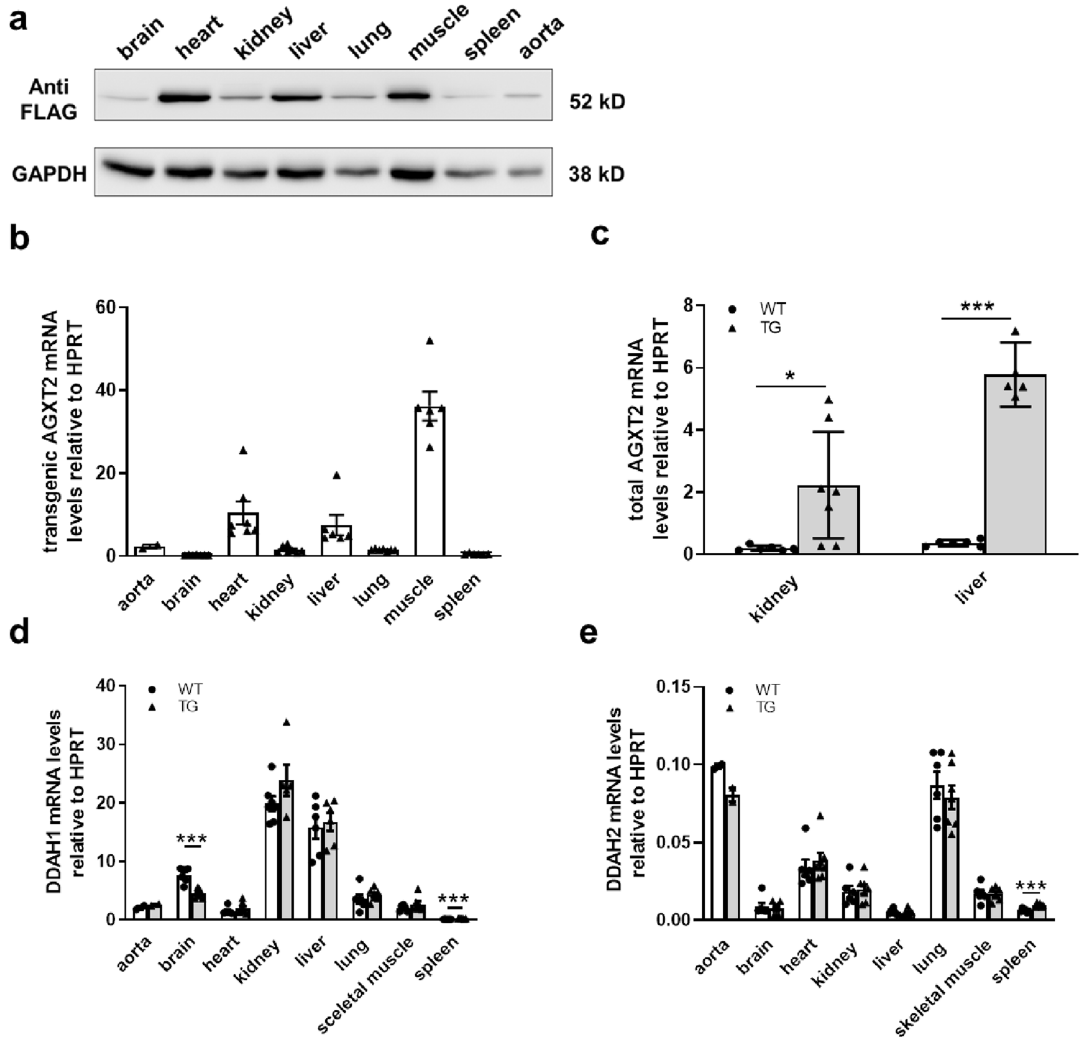
Figure 2. ( a ) Distribution of AGXT2 transgene in different tissues of TG mice, detected by Western blotting. ( b ) Distribution of AGXT2 transgene in various tissues of TG mice, detected by qPCR, n = 5–7 per group. ( c ) Expression of total (endogenous and transgenic) AGXT2 in kidney and liver of transgenic and wild-type mice. ( d ) Expression of DDAH1 and DDAH2 ( e ) in various tissues of TG mice, detected by qPCR. *p < 0.05; ***p < 0.001; One-way ANOVA followed by Tukey’s multiple comparison test ( c – e ). N = 6–7 ( a ), 5–7 ( b – d ). Cohen’s d = ( c ) 1.7 (kidney) and 10.2 (liver), ( d ) 3.4 (brain) and 2.2 (spleen); ( e ) 2.3